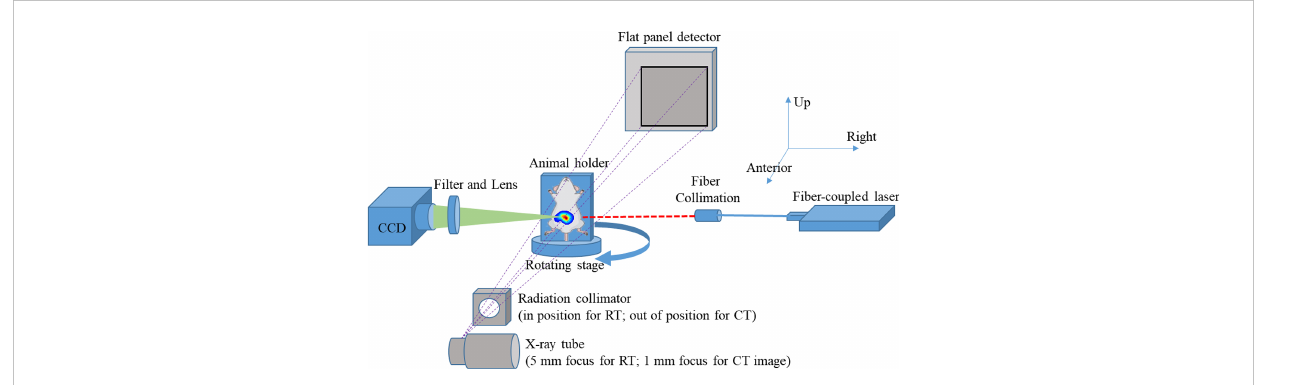
FIGURE 1 Schematic diagram of the multimodal CT/FMT imaging and image-guided irradiation